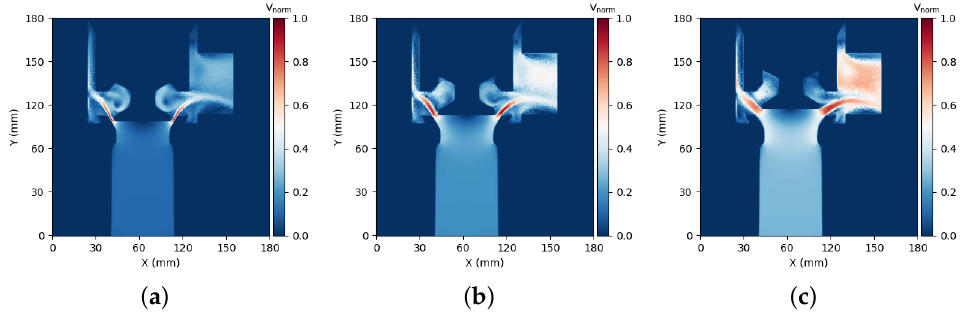
Figure 9. Discharging valve velocity field under different spool displacements: ( a ) h = 5 mm; ( b ) h = 10 mm; ( c ) h = 15 mm.